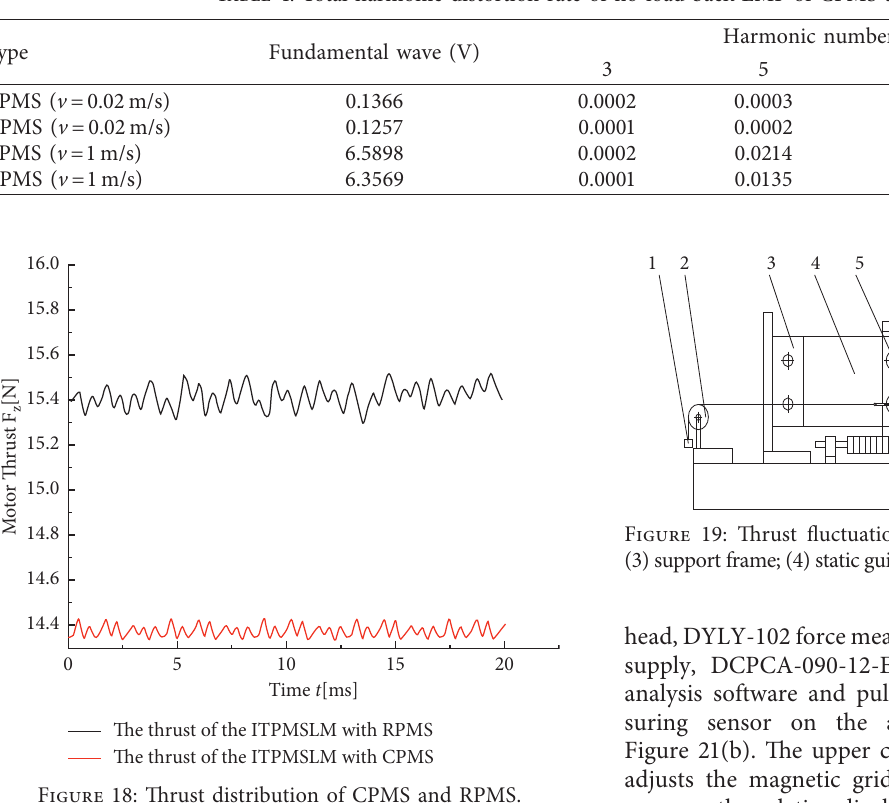
Figure 17: No-load back EMF distribution of CPMS and RPMS: (a) v � 0.02m/s; (b) v � 1m/s. Table 4: Total harmonic distortion rate of no-load back EMF of CPMS and RPMS.